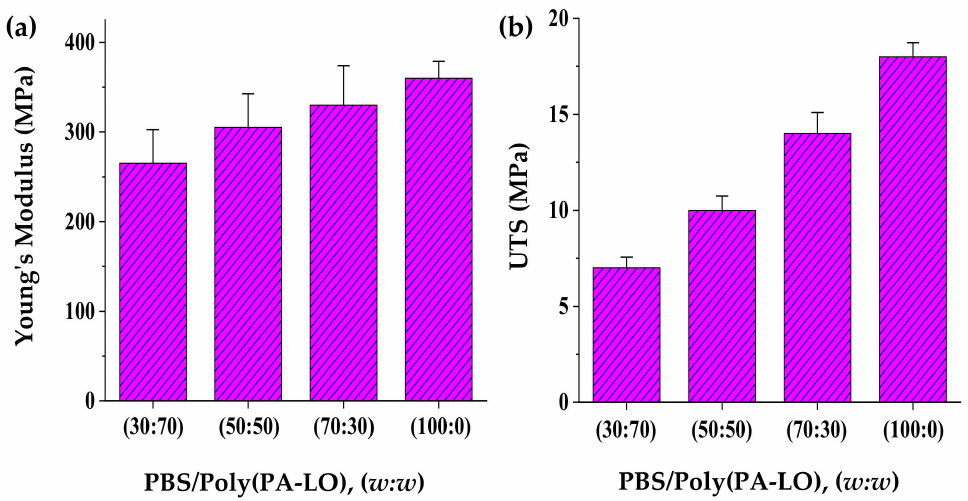
Figure 12. Comparison of the Young modulus ( a ) and the maximum strength ( b ) of neat PBS and the three studied PBS/poly(PA-LO) blends.